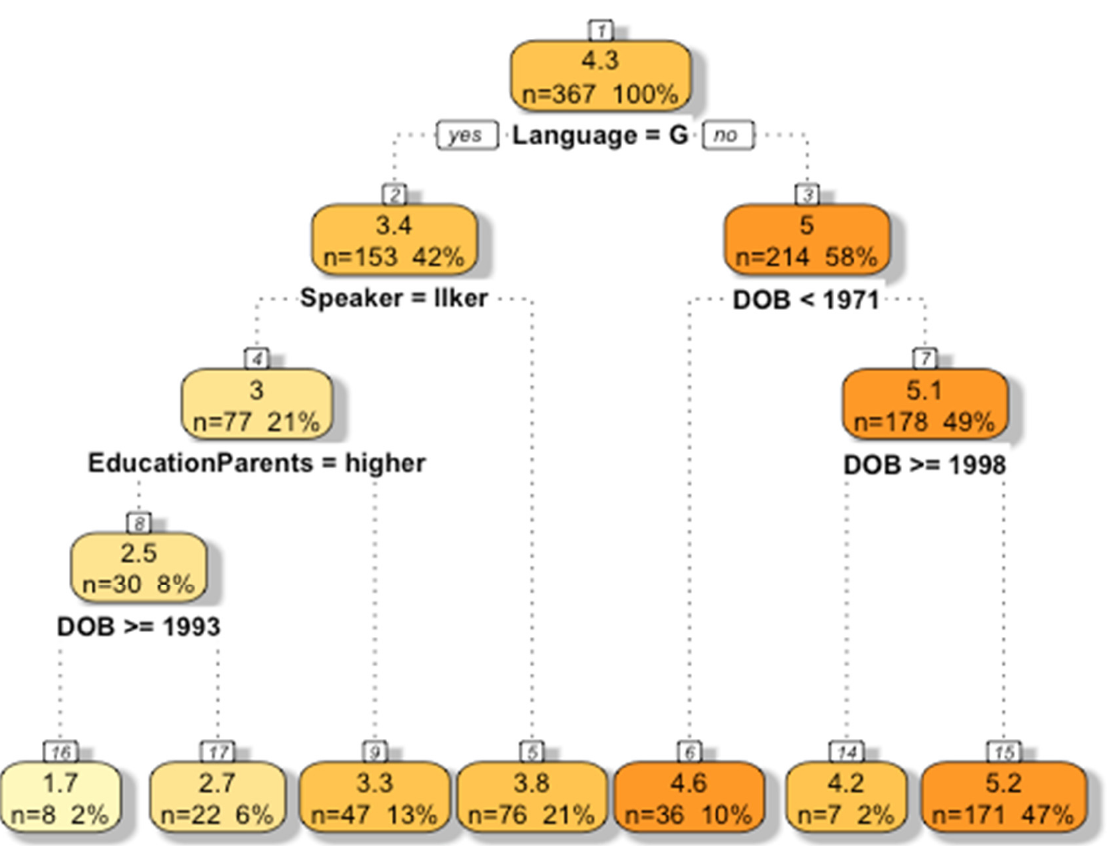
Figure 3. Recursive partitioning tree predicting the “archaic migrant” score. Starting at the root of the tree, the reader can follow the tree downwards by making binary decisions to arrive at the final predicted score. For instance, for a participant born before 1971 who listened to the Turkish guise, the predicted score for “archaic migrant” is 4.6. For an in-depth discussion, see Breiman et al. (1984).